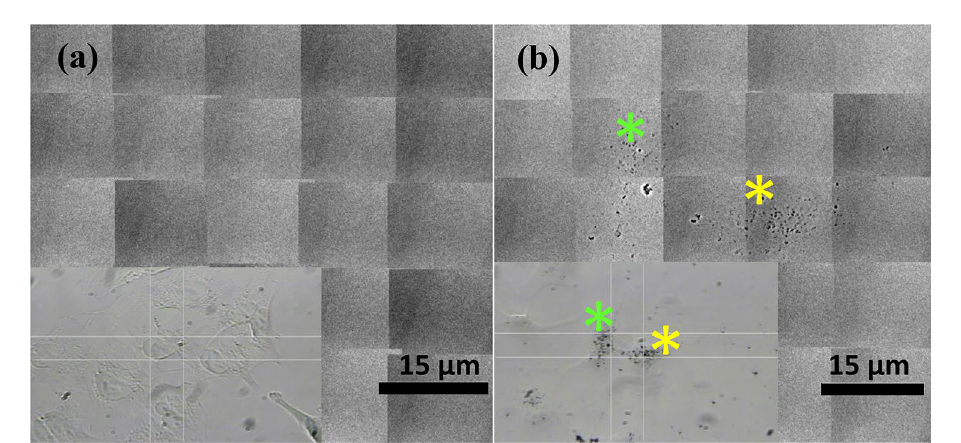
Figure 6. High resolution X-ray micrograph of A549 lung cancer cells cultured with ND@Au. Untreated control ( a ) and cells incubated with 50 µg/ml ND@Au for 24 h ( b ). The color stars mark the corresponding areas in X-ray and optical